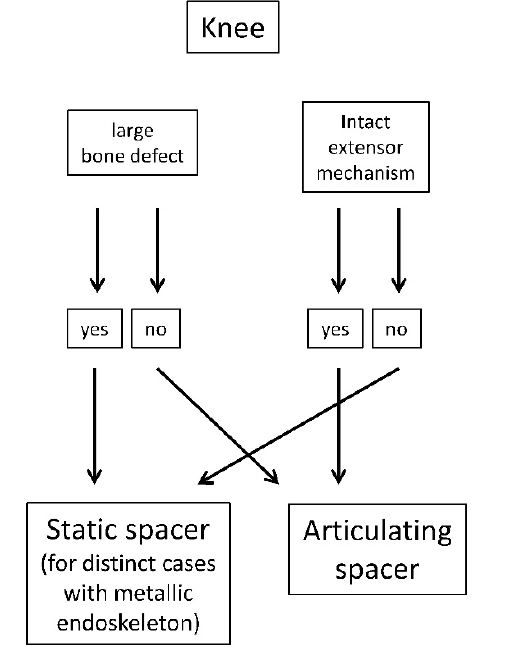
Figure 3: Criteria for knee spacer implantation.